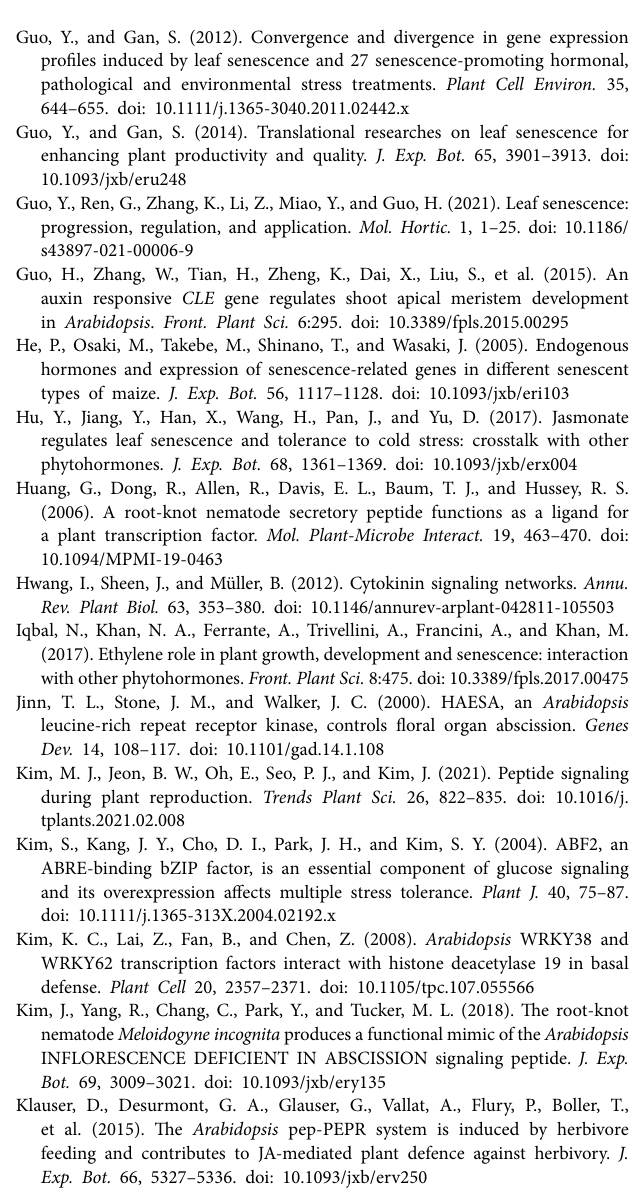
Supplementary Figure 1 | Sequence information of the IDL6 peptide. Supplementary Figure 2 | Growth of wild-type, idl6 mutant and a complementary line on 1/2 MS medium containing Kanamycin. Supplementary Figure 3 | The relative expression of WRKY53 , CDF4 , WRKY38 , and WRKY62 in wild-type, idl6 mutant, rescue and overexpression lines. Supplementary Figure 4 | The expression levels of RBCS and SAG12 in wild- type and overexpression plants under dark treatments. Supplementary Figure 5 | The senescence phenotypes of detached leaves treated with 1 μ M and 10 μ M IDL6 peptides. (A) The detached leaves from wild type of Arabidopsis exhibited early senescence under IDL6 peptide treatments. Leaves were kept in a growth chamber at 23 ° C with continuous light. Changes in chlorophyll content (B) and photosynthetic rate (C) in the treated leaves. Significant differences compared with the Mock were determined by Student’s t -test (* p < 0.05, ** p <